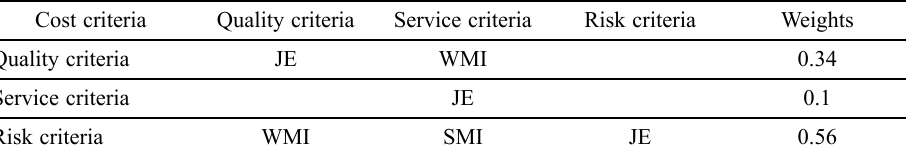
Table 8. Inner-dependency matrix of the criteria with respect to “cost”